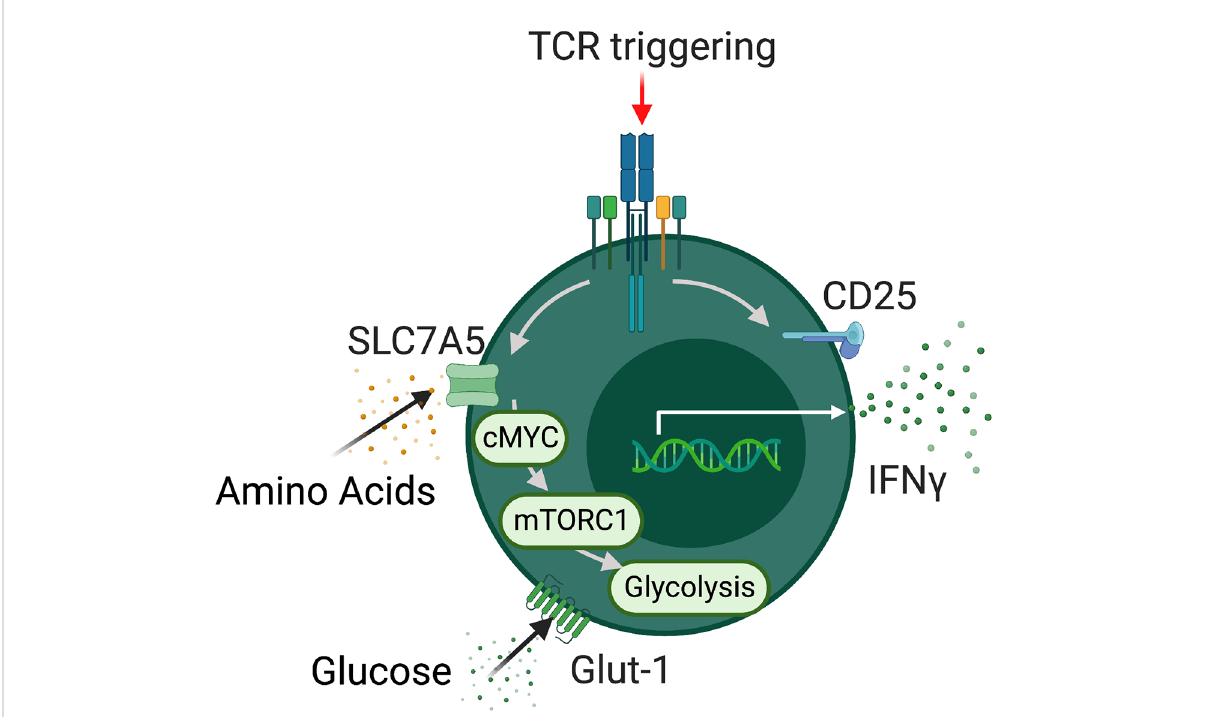
FIGURE 1 MAIT cells metabolism. Schematic detailing metabolic programming in TCR activated MAIT cells. Activated MAIT cells upregulate a range of nutrient transporters including SLC7A5 and GLUT-1 followed increased rates of glycolysis which support effector function. In addition MAIT cell metabolic programming is dependent on the metabolic regulators mTORC1 and